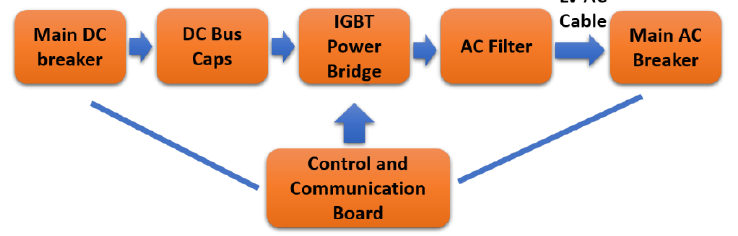
Figure 6. Generalized structure of inverters.